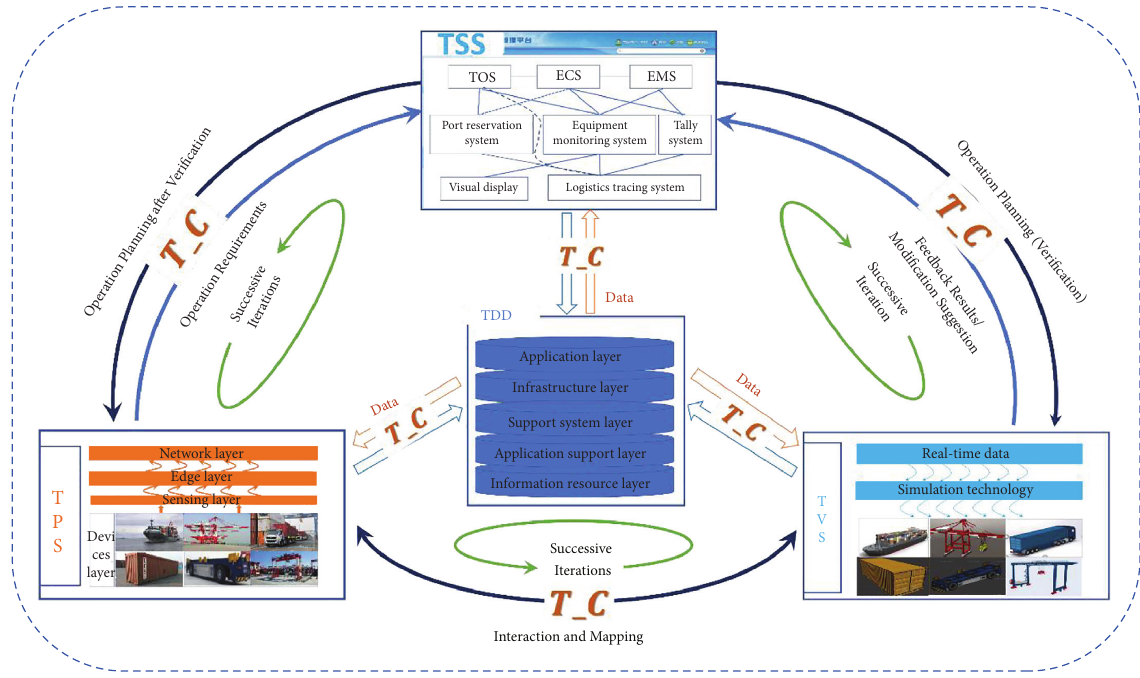
Figure 1: A DT reference model (DT − TPOS) for ACT production